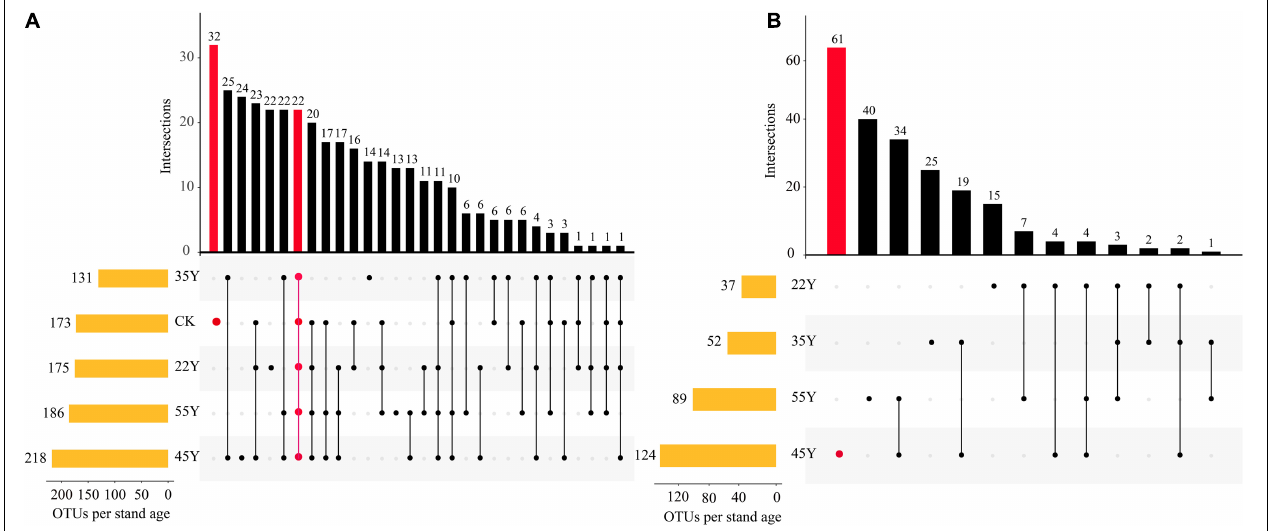
FIGURE 3 | UpSet plots show the relationships of AM fungi OTUs between rhizosphere soils (A) and roots (B) of teak along a chronosequence. The left panel displays orange bars for each stand age that represent the number of AM fungi OTUs. Dark circles in the matrix indicate sets of treatment that intersect. The two intersection queries are the one-way intersection of CK (red) and the five-way intersection of all 5 stand ages in the rhizosphere soils. The one intersection query is the one-way intersection of 45Y (red) in the